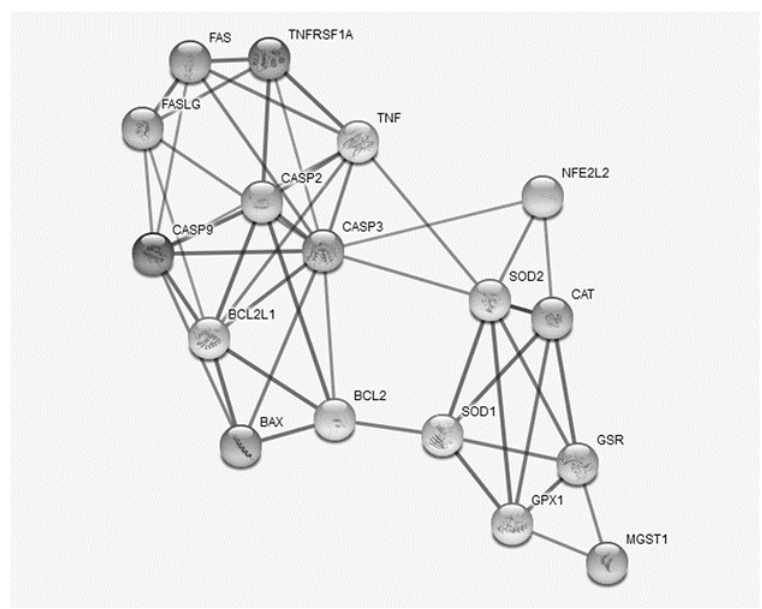
Figure 2. The protein interaction network created in a STRING database. The thickness of the line between the proteins indicates the degree of confidence prediction of the interaction.